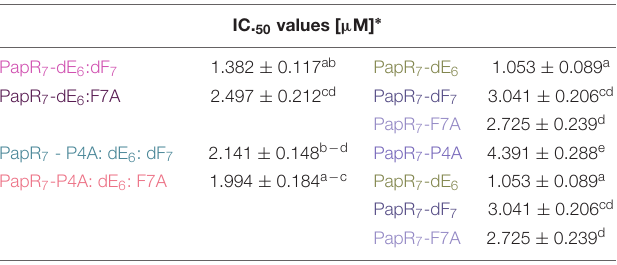
TABLE 2 | Comparison between IC 50 values of new PapR 7 -derived peptide combinations and their parent inhibitors, as determined by the hemolytic